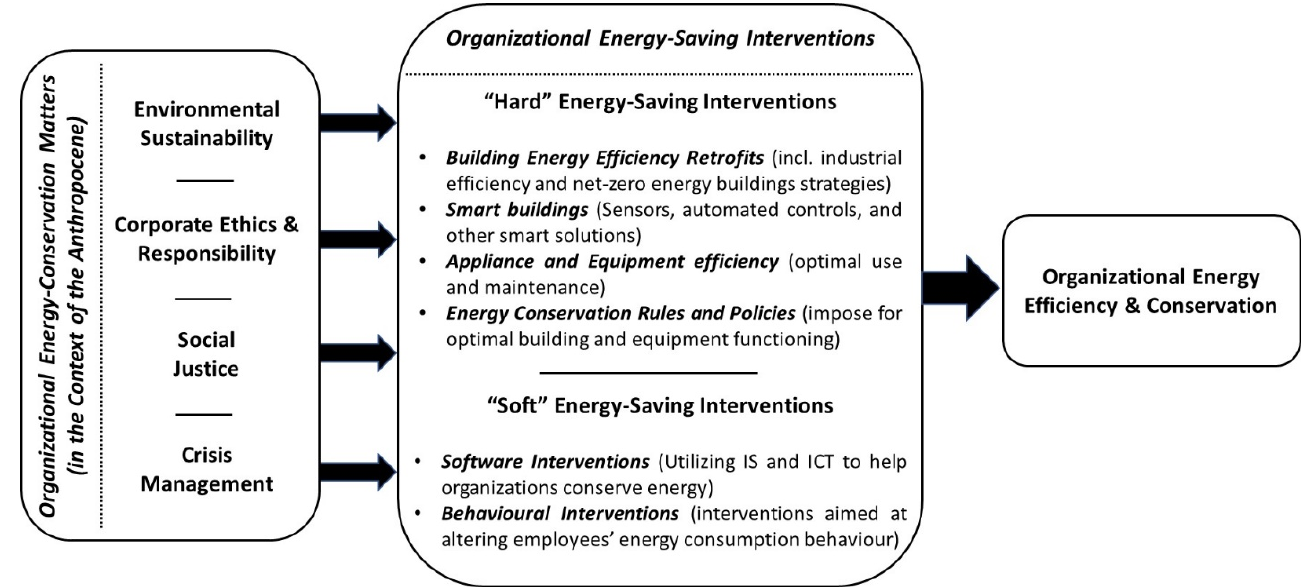
Figure 6. A guide for research and practice in organizational energy efficiency and conservation.